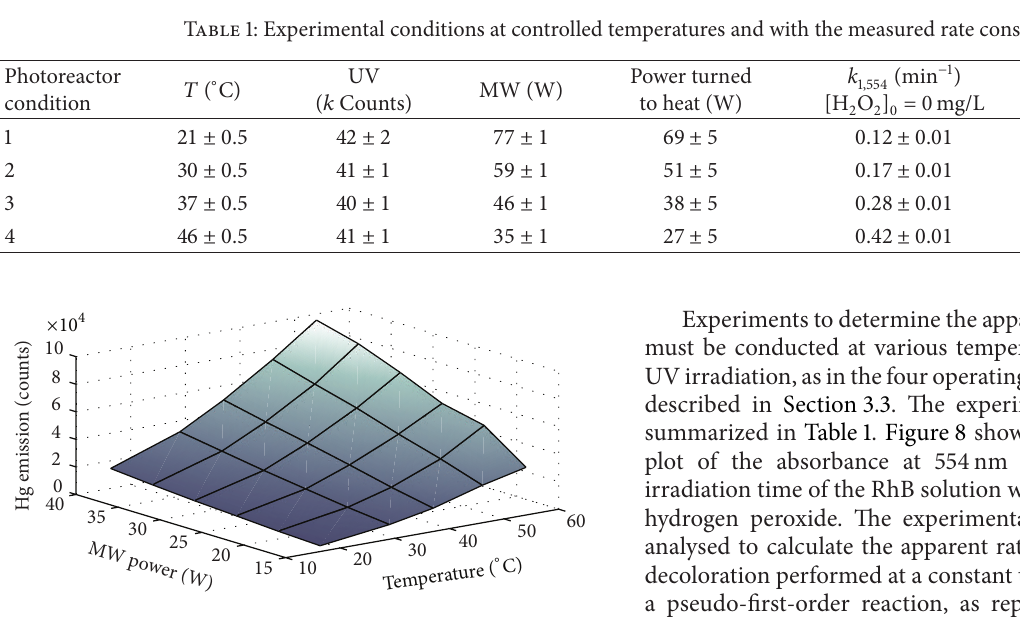
Figure 7: Three-dimensional plot of the integrated area of the UV emission line in the 250–256 nm range as a function of temperature and MW